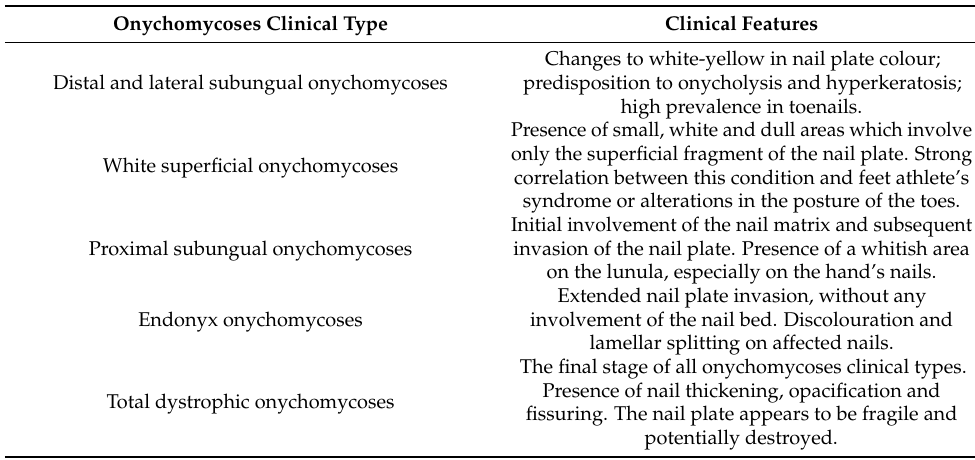
Table 1. Clinical features of onychomycoses different